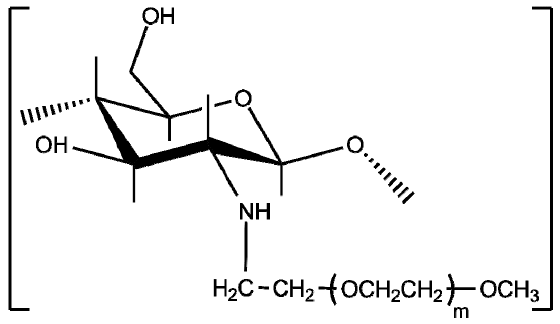
Figure 9. Chemical structure of chitosan- g -poly(ethylene glycol).